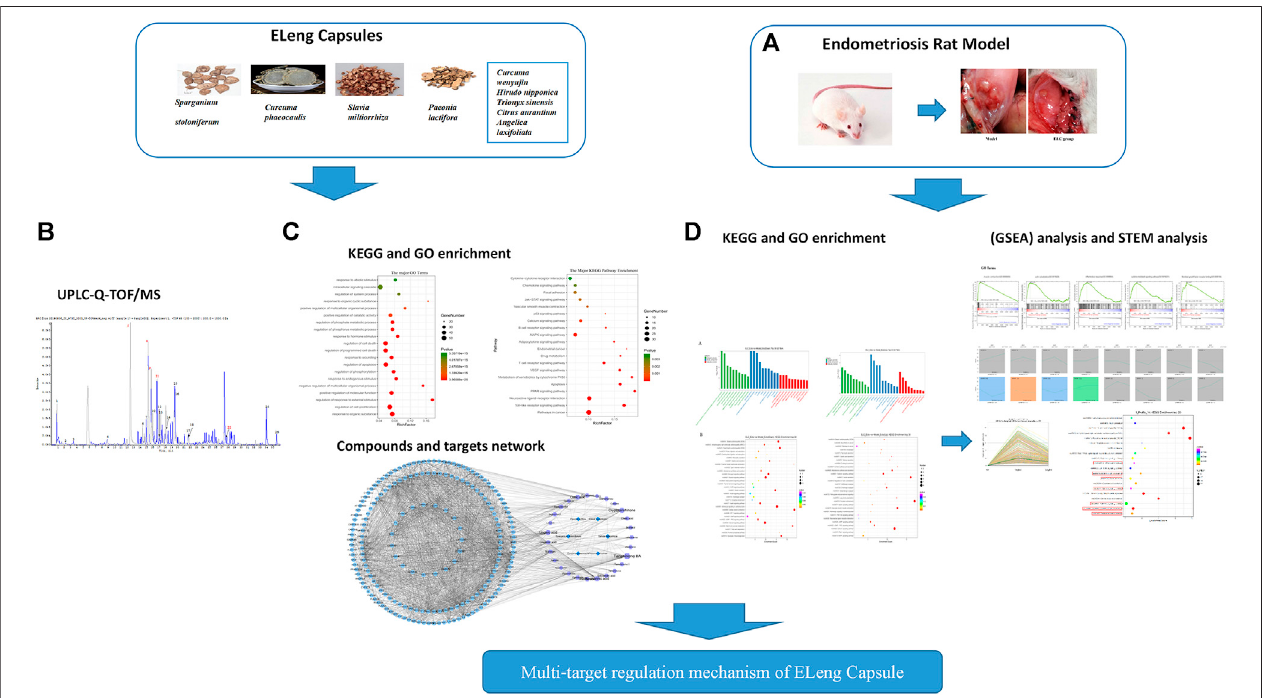
FIGURE 1 | Work fl ow of network pharmacology combined with the RNA-sequence approach. (A) Endometriosis model rats were established and used to verify the core targets. (B) The compounds ofELCswere identi fi ed by ultra-performanceliquid chromatography/quadrupole time-of- fl ightmassspectrometry(UPLC-Q-TOF/ MS). (C) Network pharmacology was used to analyze the compounds-targets network of ELC. (D) RNA-sequencing was used to identify differentially expressed genes (DEGs). Biological functions and pathways were determined through gene ontology and Kyoto Encyclopedia of Genes and Genomes (KEGG) pathway analyses. Gene set enrichment analysis (GSEA) and STEM analysis were used to further analyze the genetic network and modular genetics.